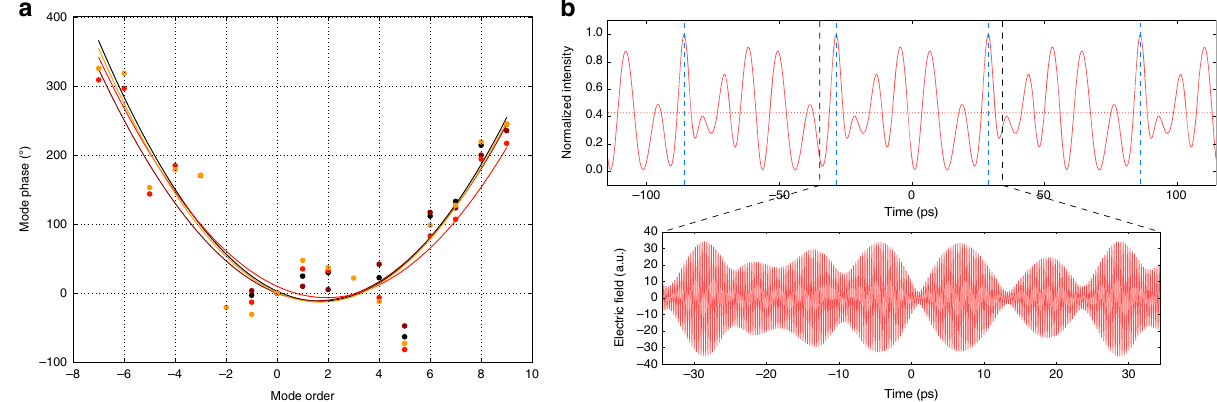
Fig. 4 Measured phases. a Measured phases of each emitted mode. Different colors represent sets of measurements collected during different days and under different operating conditions. b QCL output intensity pro fi le and electric fi eld, reconstructed through one of the sets of phases shown in a